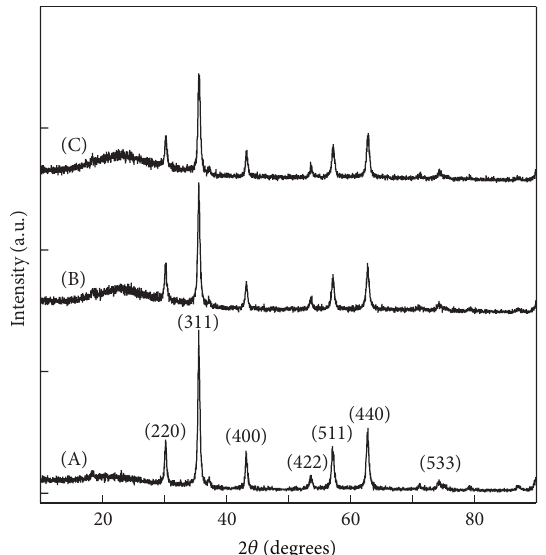
Figure 3: X-ray diffraction patterns of pure Fe 3 O 4 nanoparticles (A), MFMSNs (B), and MFMSNs-HP